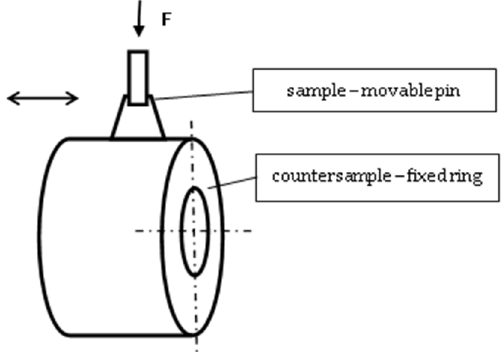
Figure 1. Scheme of analyzed friction node.